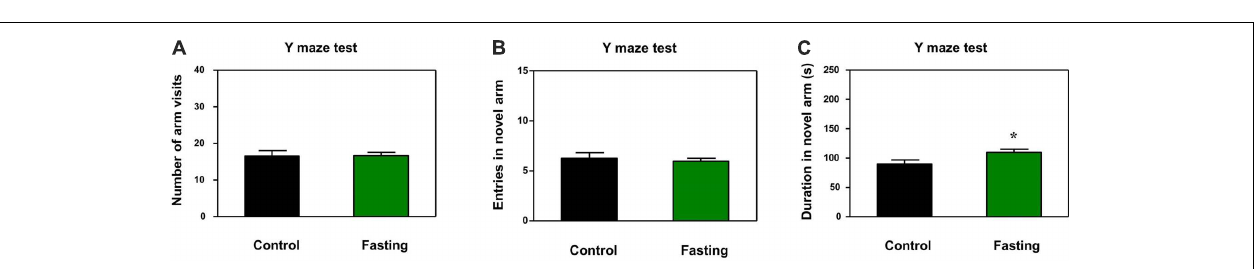
FIGURE 4 | Acute fasting enhances the learned behavior of mice in the Y-maze test. The graphs are showing the number of arm entries (A) , novel arm entries (B) and duration in the novel arm (C) . Note that 9-h fasting significantly elevated the duration in the novel arm as compared to the control condition. Data are shown as means ± SEM (Student’s t -test; ∗ p < 0.05; n = 12–16